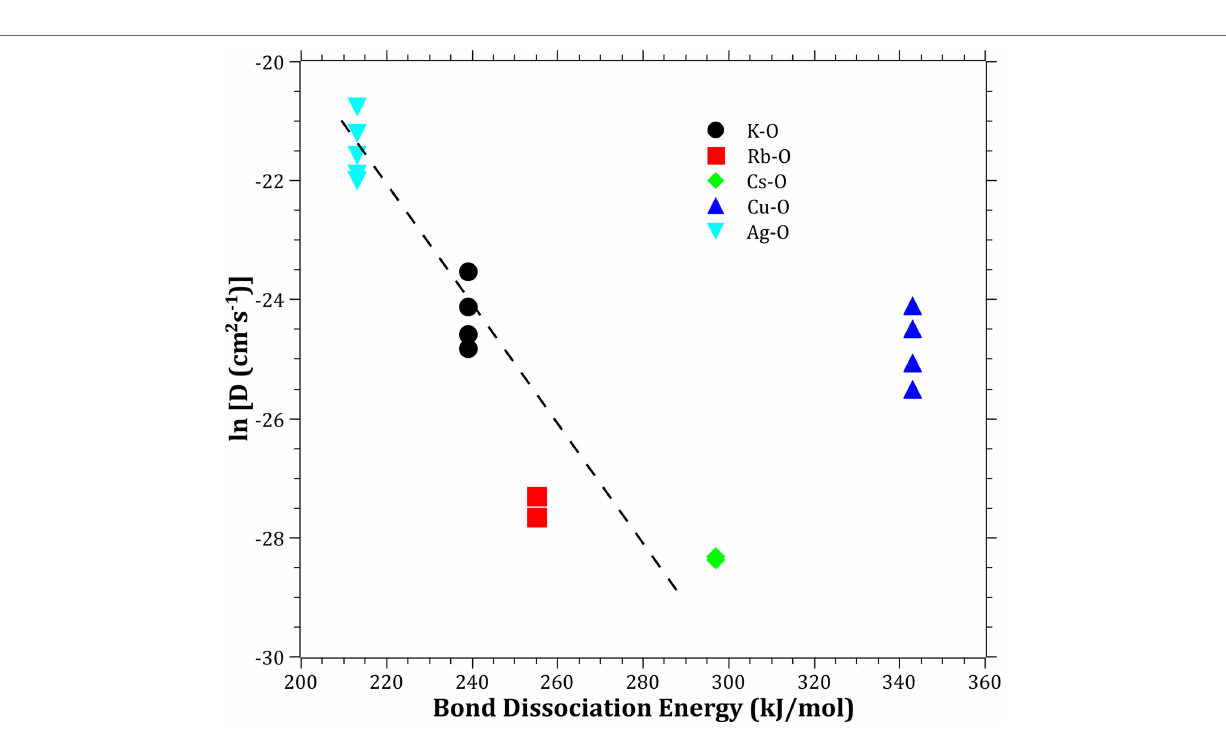
FiGUre 7 | Logarithm of the effective diffusion coefficient vs. bond dissociation energy . Data taken from Dean (1999). The dashed line is a guide to the